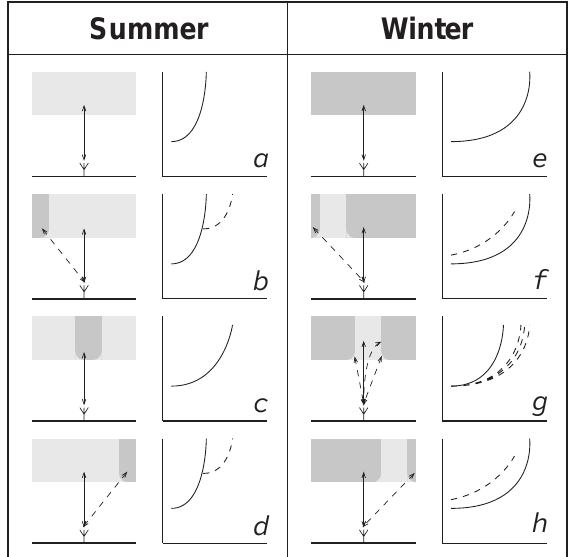
Fig. 11. A schematic figure showing the relationship of the po- lar patch to the ambient “tongue of ionisation” in summer months and winter months. For summer and winter a sequence of diagram is shown, each a cut along the south–north (left–right) meridian, with the ionosonde shown at the bottom. Higher and lower electron densities are indicated by darker and lighter shaded regions. The reflected ionosonde signals are shown by arrows, solid arrows in- dicating reflection above, and dashed arrows off-zenith returns. To the right of each diagram is the ionogram expected from the indi- cated radio propagation, solid and dashed traces corresponding to overhead and off-zenith returns. In summer, the tongue of ionisa- tion is of relatively low density and polar patches are occasional enhancements above this background level. In winter, the tongue of ionisation is of high density, and patches are defined by short depletions in this electron